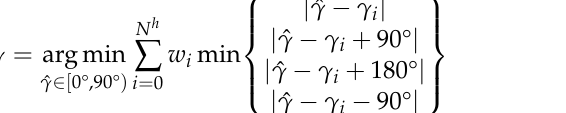
Figure 3. The normal vectors (cid:126) n i of the triangle mesh shown in Figure 2 visualized as an extended Gaussian image (thinned out by a factor of 25 for the sake of visibility). The normal vectors (cid:126) n h that i are horizontal within the range of ± 45° are visualized in black, while the others are visualized in gray. The coordinate axes are visualized in red for (cid:126) x , green for (cid:126) y , and blue for the vertical axis (cid:126) z . These horizontal normal vectors (cid:126) n h can subsequently be projected to the i